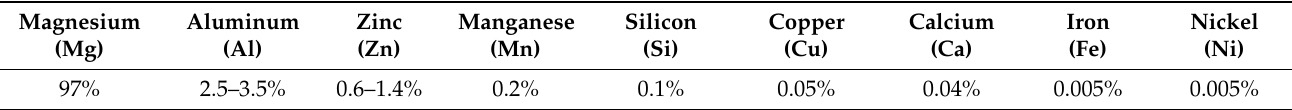
Table 1. The chemical composition of magnesium alloy AZ31B